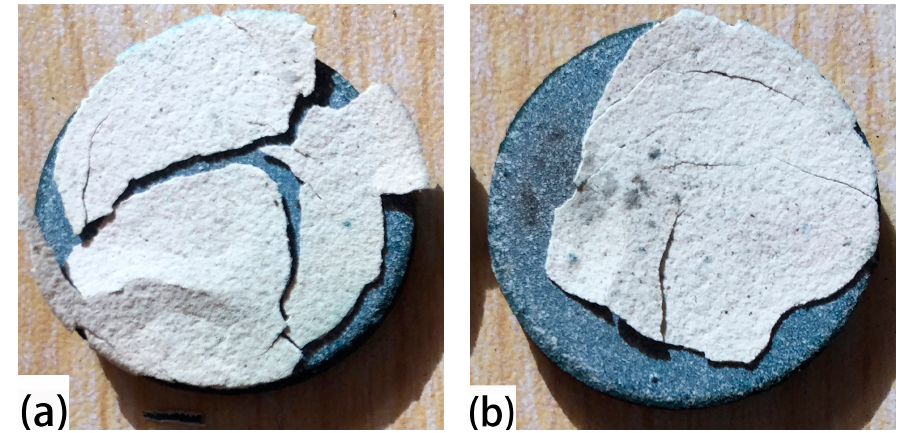
Figure 5. The macroscopic morphologies of failed TBCs: ( a ) type A and ( b ) type B.